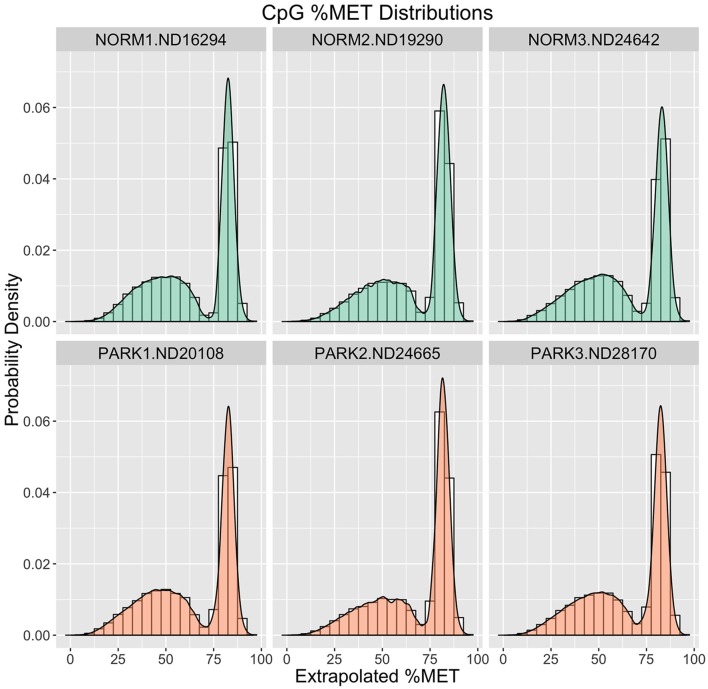
Methylation (%) Frequency Distributions. Sample profiles for %MET as a frequency distribution (histogram) overlaid with a probability density distribution function (filled logistic curve). Orange = Parkinson's Patients. Green = Normal Healthy Males.